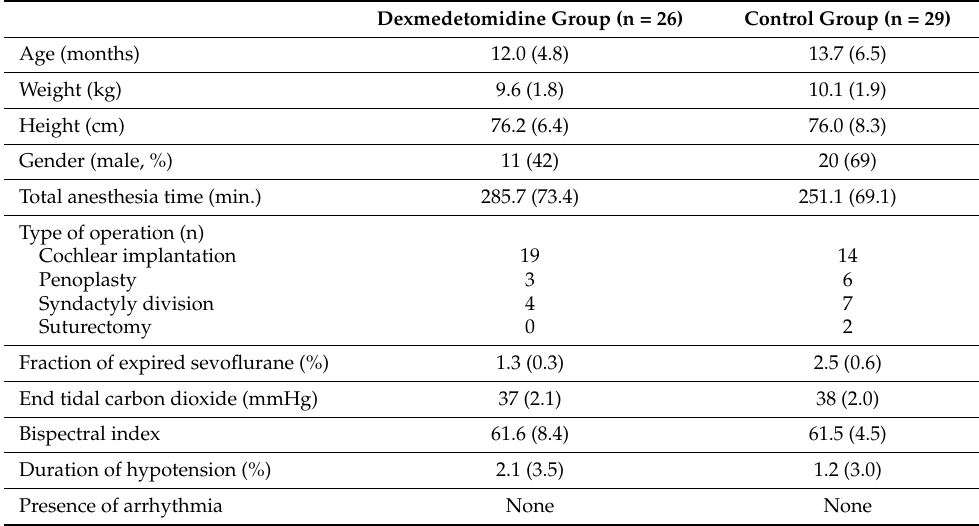
Table 1. Baseline demographic and clinical characteristics for each group.